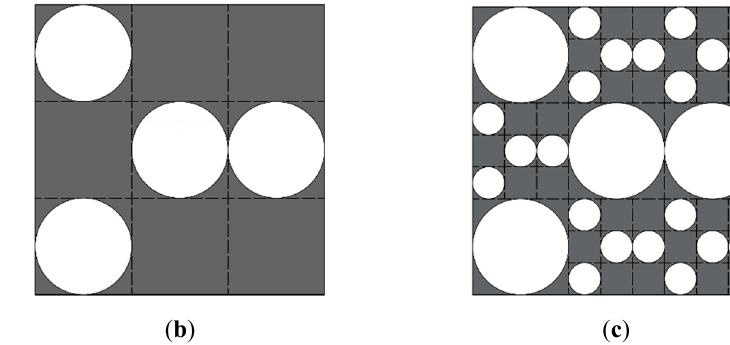
Figure 2. Construction process of solid fractal model with circular-based pores: ( a ) 0th generation; ( b ) 1st generation; ( c ) 2nd generation.